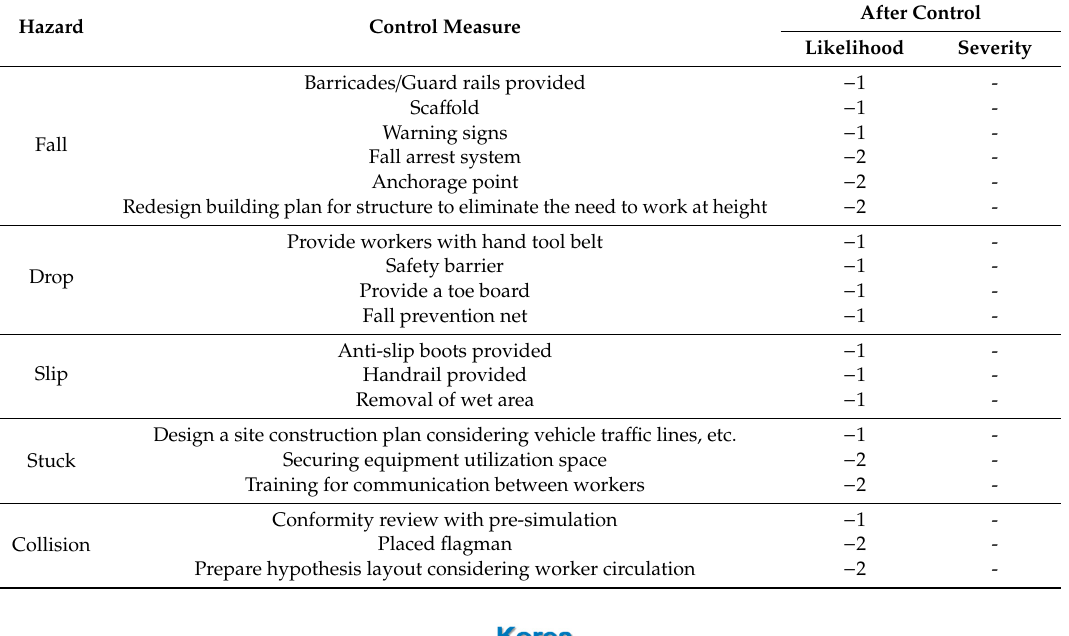
Table 4. Reduction weights by control measure